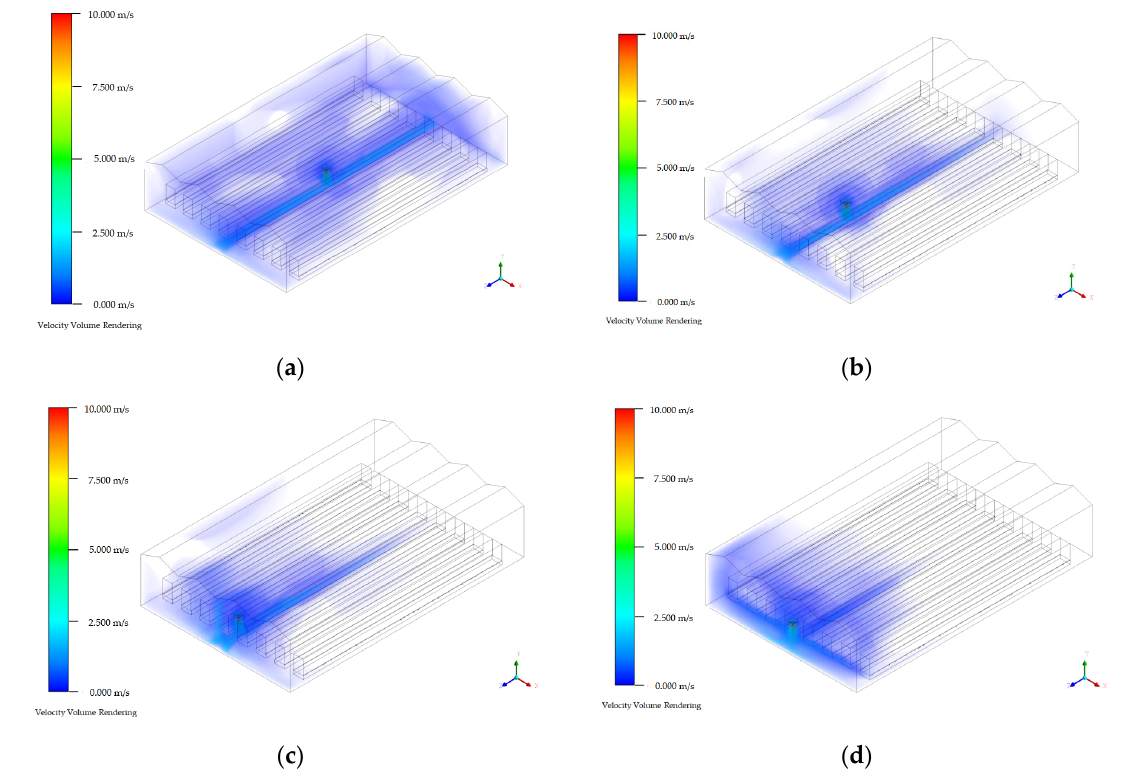
Figure 11. Speed volume rendering. ( a ) In the middle of the row; ( b ) in the quarter of the row; ( c ) at the end of the row; ( d ) in the aisle.